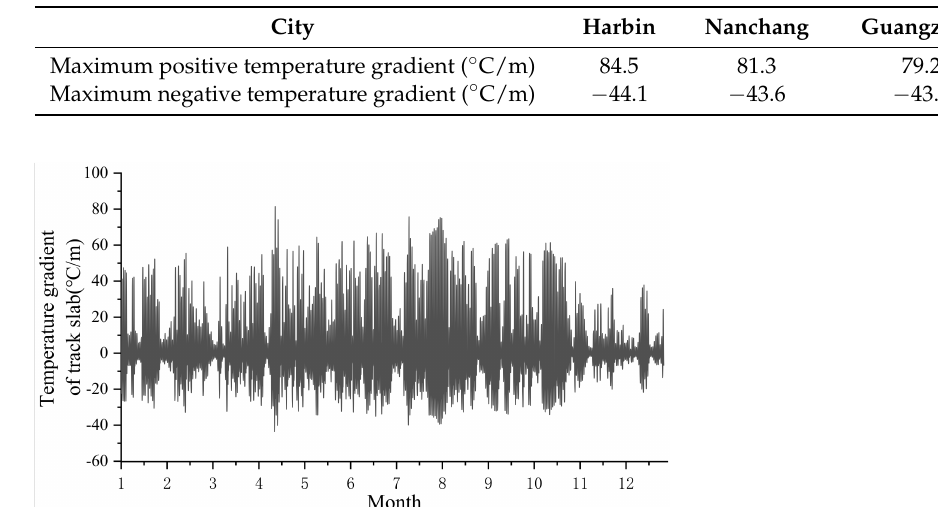
Table 2. Extreme temperature gradient.